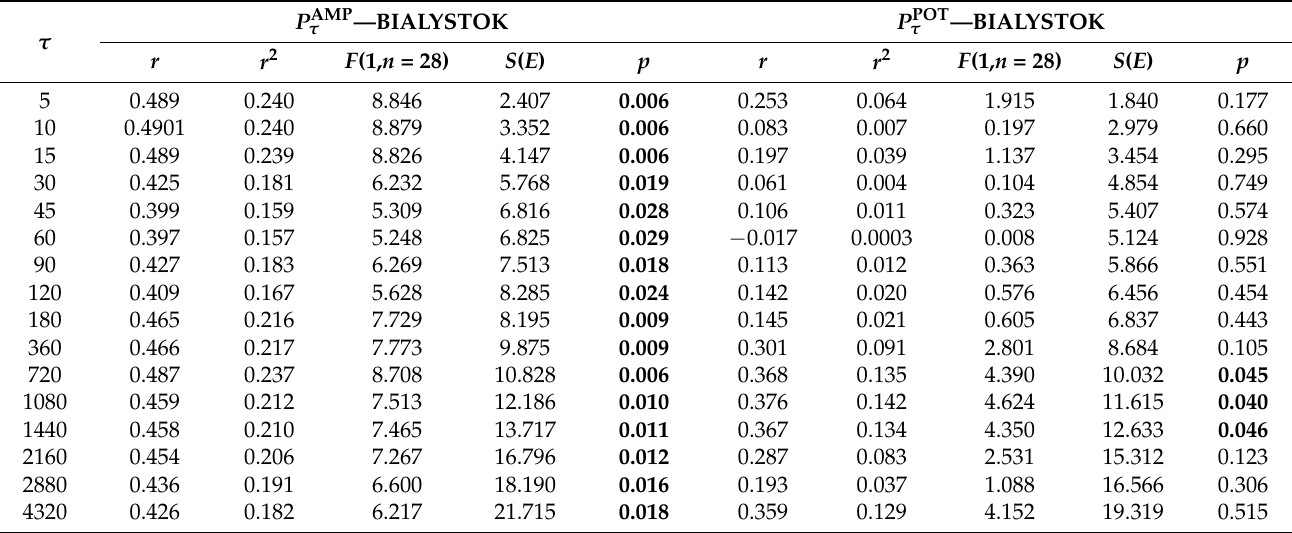
Table 6. Results of simple regression analysis for the Bialystok station, where the dependent variables are P AMP τ and P POT τ , and the independent variable is time ( τ ), for n = 30, where r is Pearson’s correlation coefficient; r 2 is the coefficient of determination; F (1, n ) is the Fisher-Snedecor test; S ( E ) is the standard error of estimation; and p ( p -value) is the value of the test probability. Bold type indicates significance of regression parameters, namely the existence (for p ≤ 0.05) of a significant influence of the variable τ on the analyzed dependent